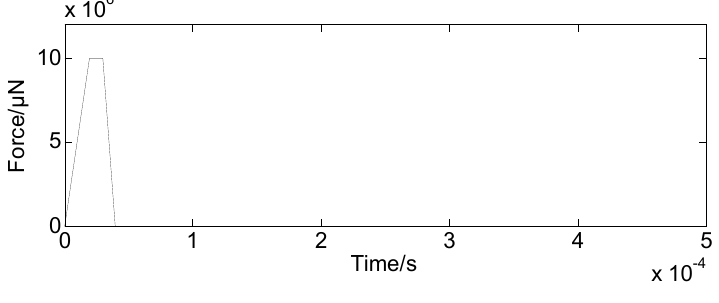
Figure 10. Force with respect to time.